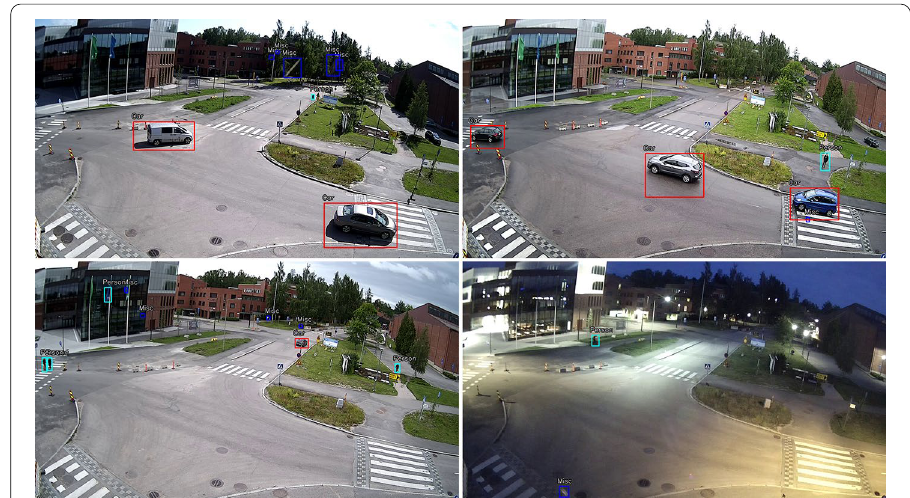
Fig. 4 Samples of detections made with MoDeCla in summer conditions